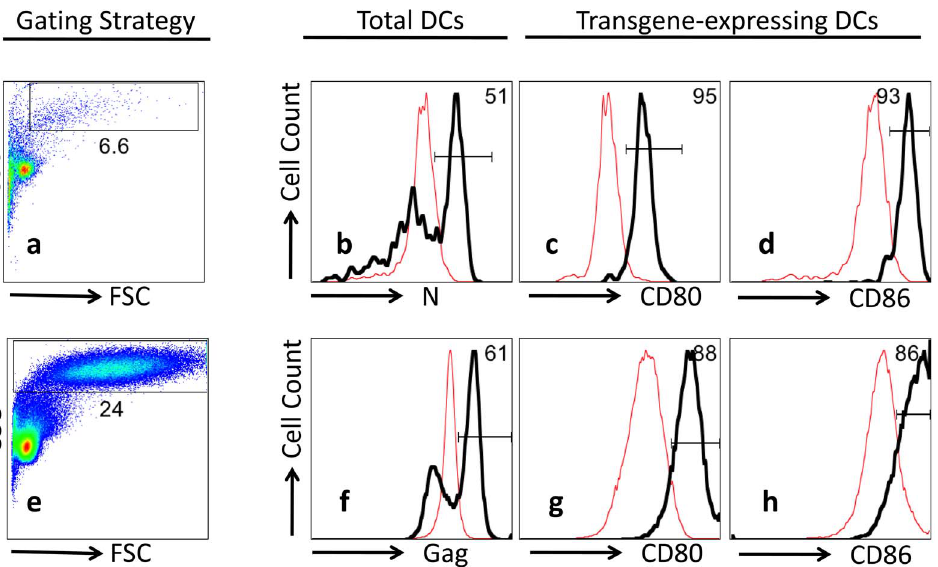
Figure 1. Expression of N protein by pLenti-vN-transduced DCs. DCs were cultured from monocytes in complete medium supplemented with GM-CSF and IL-4 for four days and transduced with a lentiviral vector encoding RVFV N ( Panels a , b , c and d) or HIV Gag ( Panels e , f , g and h ). DCs not exposed to the vector were set aside as negative (untreated) controls. Expression of transgene was assessed on day 7 by intracellular staining with N-specific mAb S-370 or Gag-specific mAb KC57. Panels a and e show the gating of DCs by forward and side scatter. Panels b and f show 51% and 61% of the DCs to expression N and Gag, respectively. Nearly all DCs expressing transgene products underwent further maturation based on increase expression of CD80 ( Panels c and g ) and CD86 ( Panels d and h